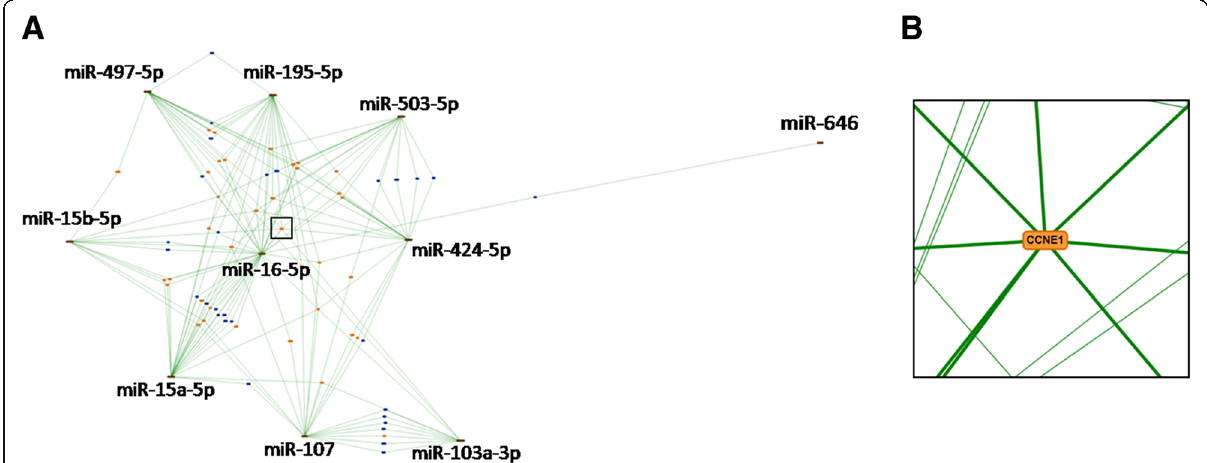
Fig. 3 The multi-miRNA and target gene interaction network for miR-15/107 family. a . The general outline of miR-15/107 interaction network calculated by miRTargetLink database based on target evidence. miRNA displayed as the edges, and target genes as the nodes of the network. Blue color refers to target genes with 2 interactions, while orange color refers to target genes with more than 2 interactions. b . Indicated central part from A was enlarged for details. Green bold lines indicate the target interactions of CCNE1 (node) from 8 various miRNAs